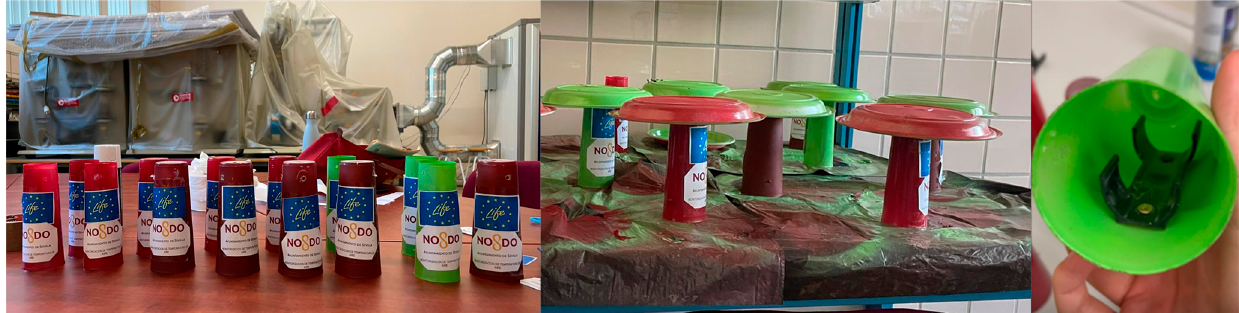
Figure 5. Preparation of the fixed sensors.